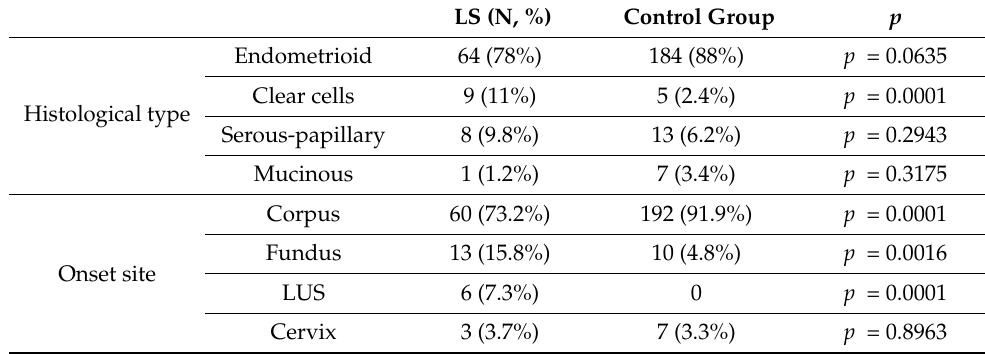
Table 3. Histological type and onset site of EC in the LS group and in the control group.